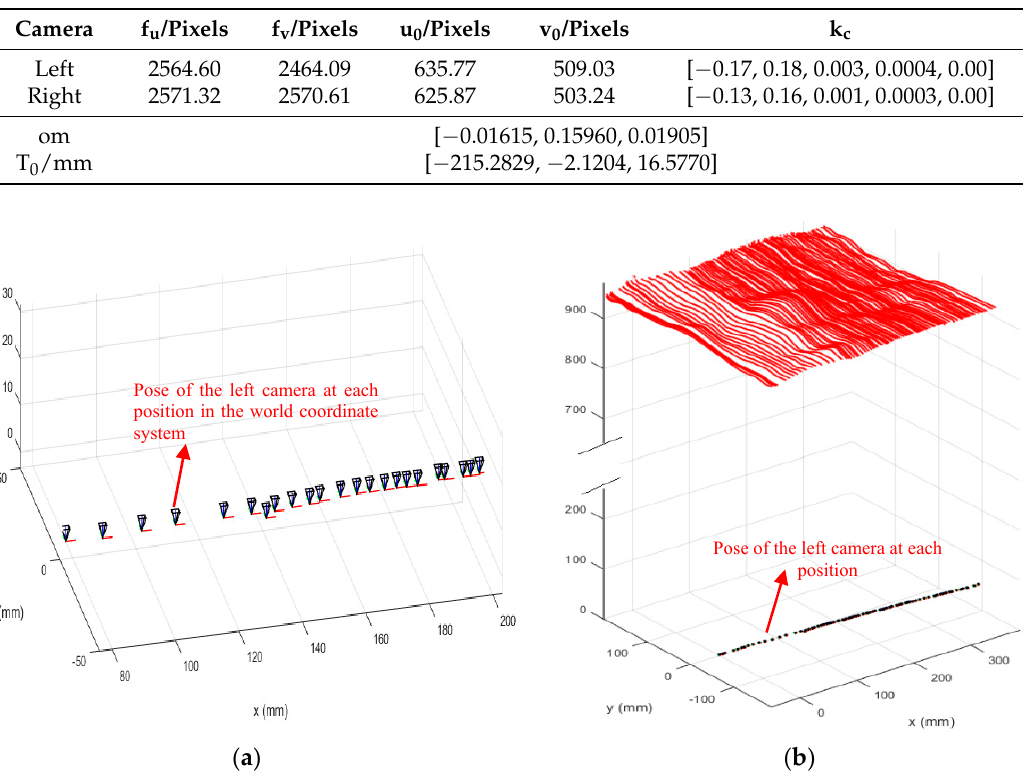
( b ) Figure 10. Reconstruction results of the flat calibration board before global optimization. Graph ( a ) shows the recovered positions of the light stripes in world coordinate system, and graph ( b ) shows the surface after triangulation and surface fitting. Figure 11 demonstrates the reconstructed surface of the board using the global optimization method: Figure 11a shows the recovered positions of the light stripes in the world coordinate system, and Figure 11b shows the plane model after triangulation and surface fitting. Figure 10 and Figure